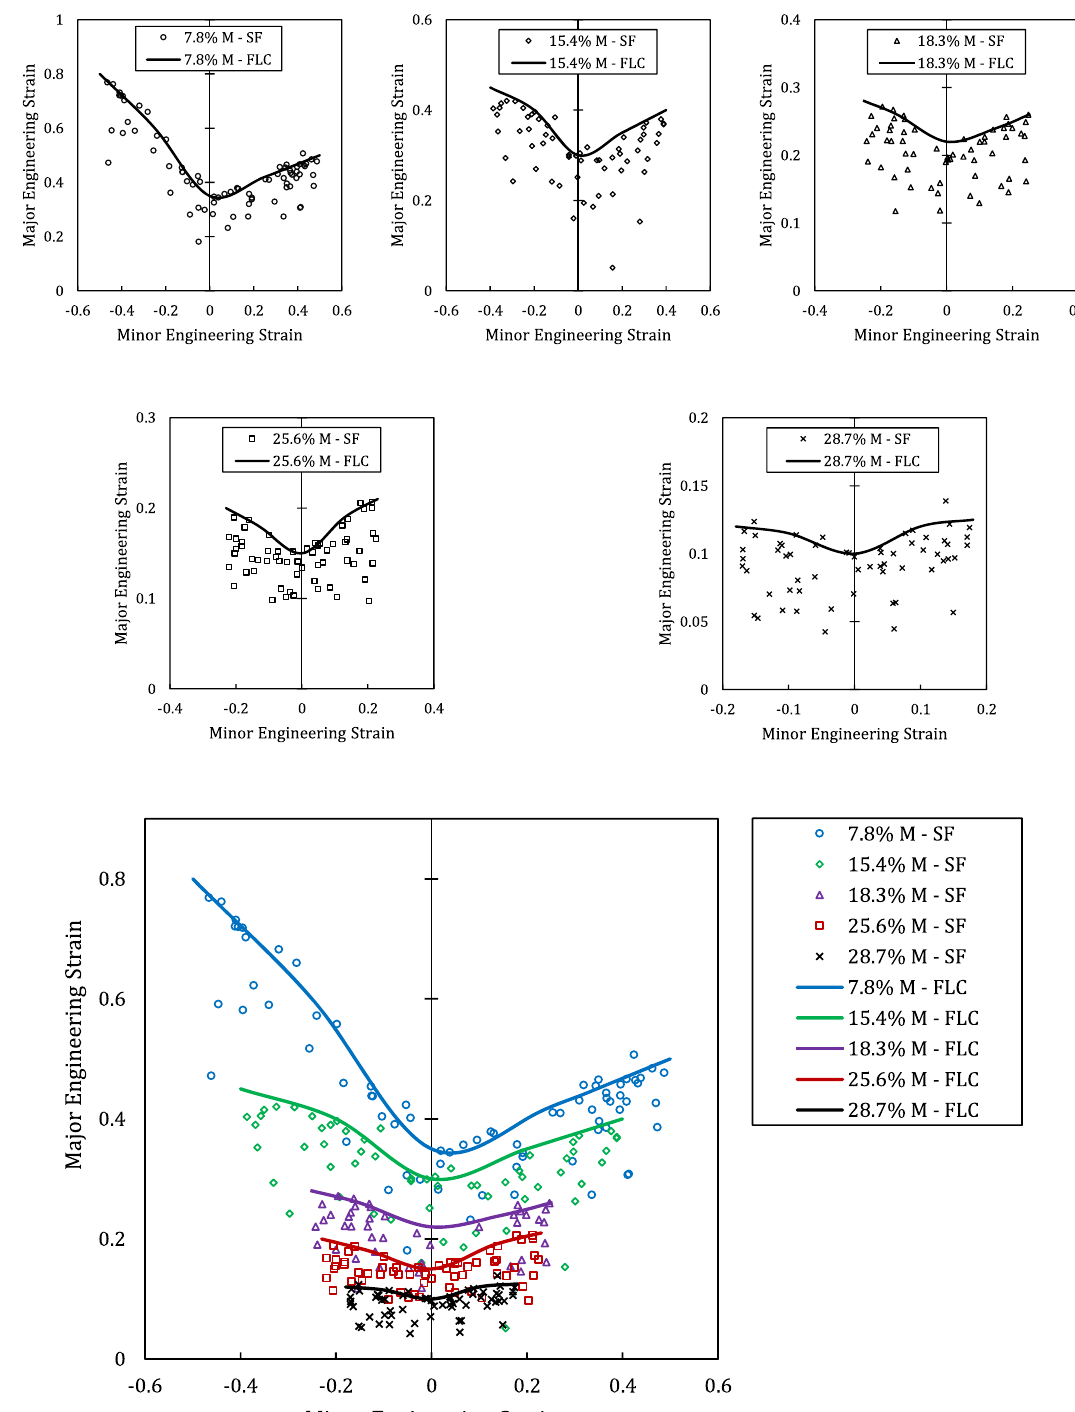
Figure 8. Foming limit curves of 316. Effect of martensite fraction on the formability of austenitic steel sheets. ( SF safe points, FLC forming limit curve, M